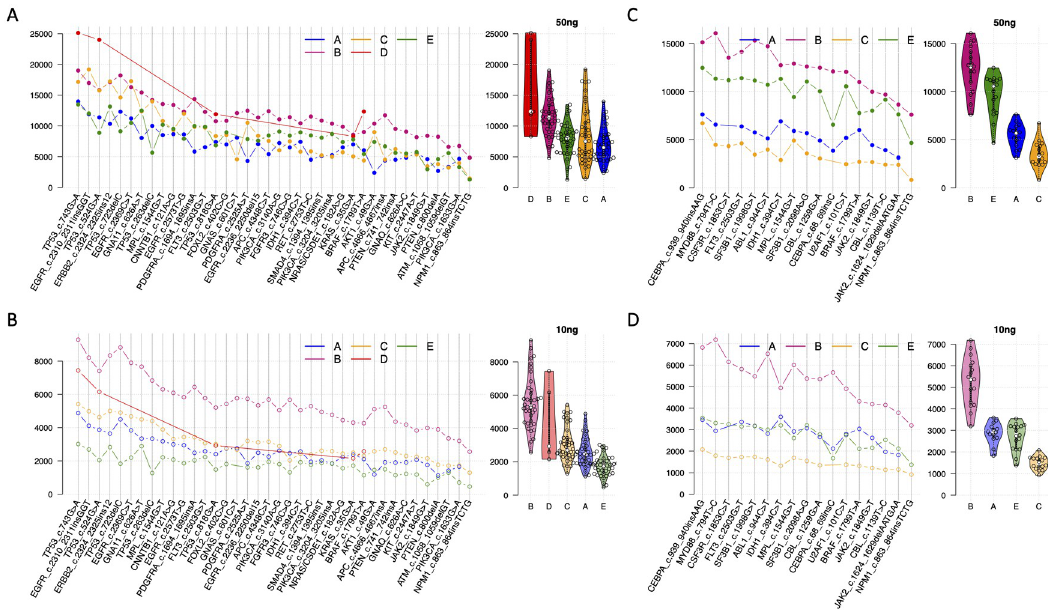
Fig 4. Depth of coverage and heterogeneity of the mutation loci. x-axis, mutation loci in sample set one or two; y-axis, depth of coverage after UMI consolidation. A, Depth of coverage of the mutation loci (line charts, left) and distribution (violin charts, right) for sample set one with 30 ng (assay A and B) or 50 ng (assay C, D, E). Assay B (pink) and assay D (red) showed higher depth of coverage than the other assays. B, Similar analysis for sample set one with 10 ng DNA input. Assay B has higher depth of coverage (light pink line, left) than the other assays across all the mutation loci and highest average coverage depth (light pink violin plot, right). C and D, Similar analysis for sample set two with 30 ng (assay A and B) or 50 ng (assay C, D, E) or 10 ng DNA input. assay B (dark or light pink lines, left) has higher depth of coverage than other assays across all the mutation loci and the highest average of coverage depth (dark or light pink violin plots, right).